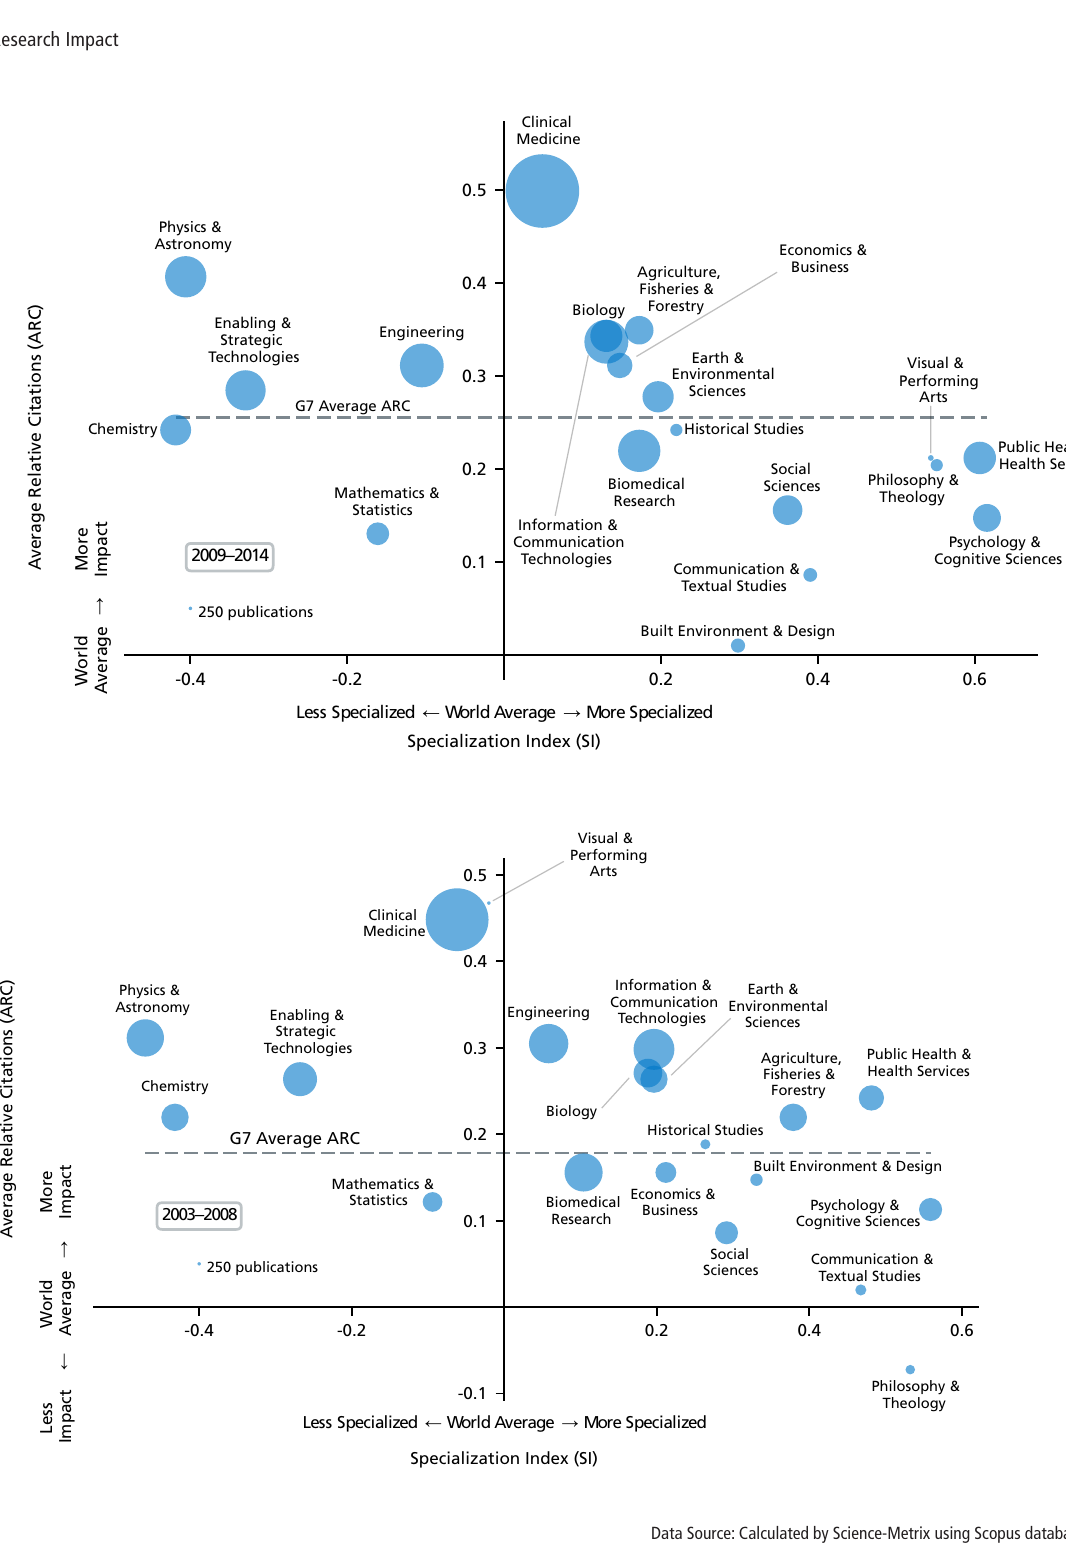
Figure 4.3 The figure was designed with the same methodology used in the 2012 S&T report. The area of a bubble is proportional to the number of publications in that field, based on whole counts. For example, Mathematics and Statistics had 10,250 publications in 2009–2014, so the area of its bubble is 41 times the reference bubble of 250 publications. ARC and SI scores are transformed to the hyperbolic tangent of the natural logarithm of the indicators to improve readability and allow for a symmetrical representation of the data. Zero is equal to the world average for both